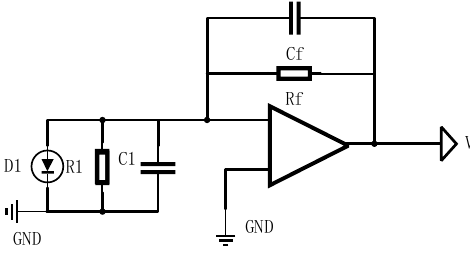
Figure 5. The schematic diagram of pre-amplifier circuit.